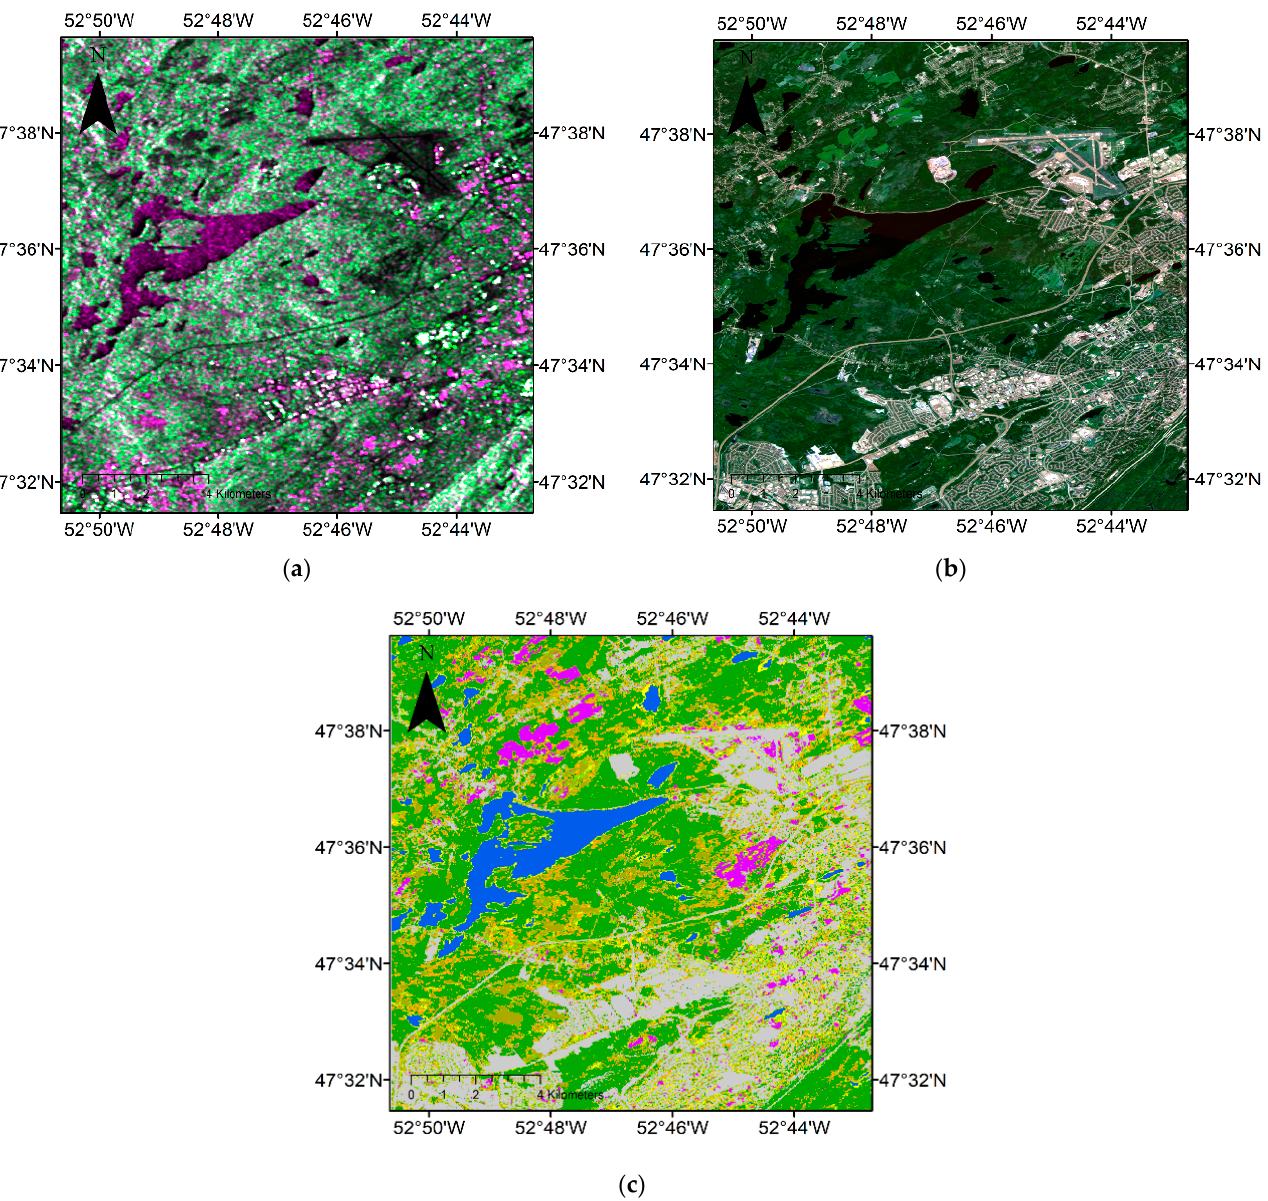
Figure 7. The selected zoom-in area (red frame in Figure 6) from ( a ) RCM (R: VV, G: VH, B: VH/VV), ( b ) Sentinel-2, and ( c ) classification map.